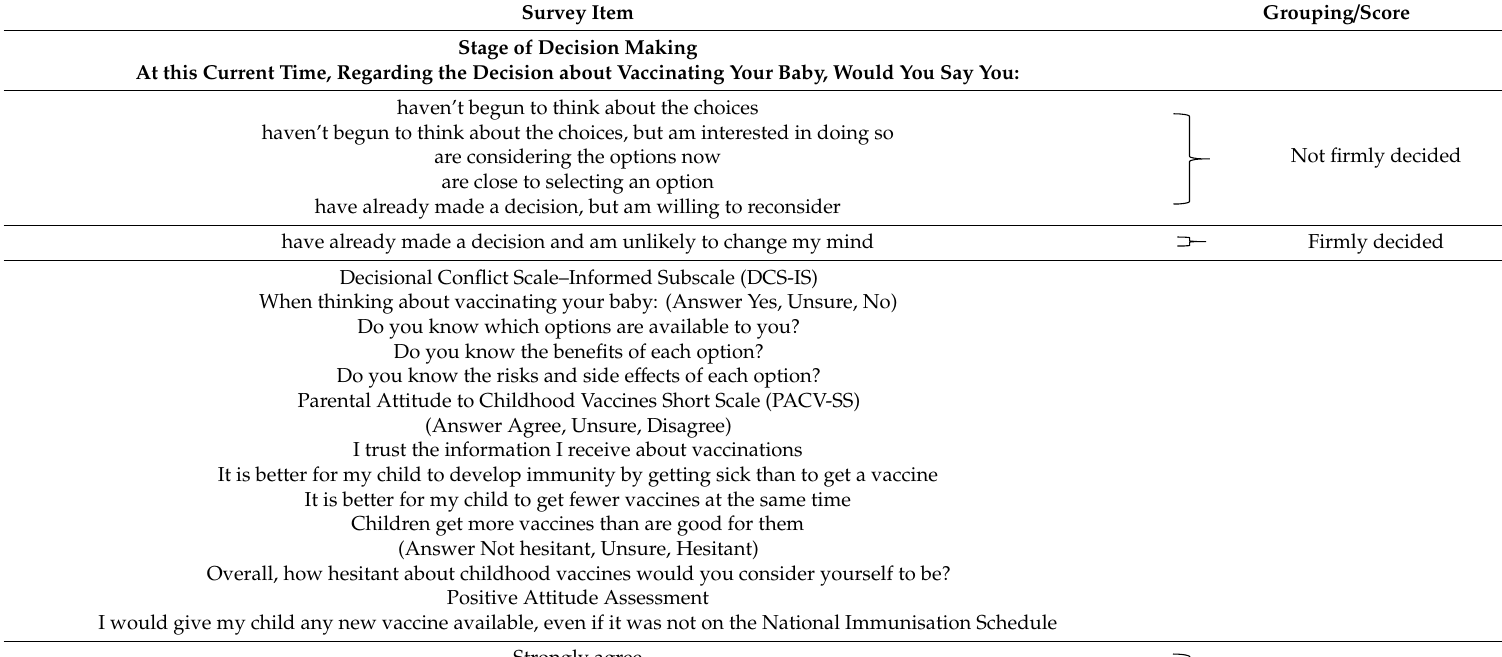
Table 1. Survey Items for Pre and Post Intervention Measures.